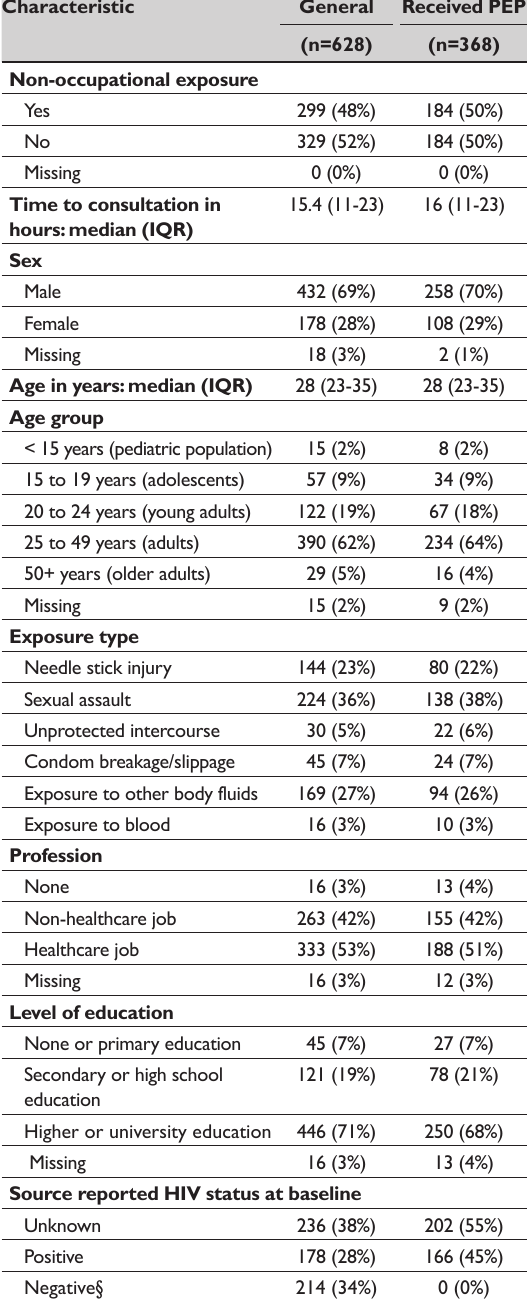
Table 1: Sociodemographic characteristics of individuals seen at Yaounde Central Hospital for Post-Exposure Prophylaxis (PEP) Characteristic